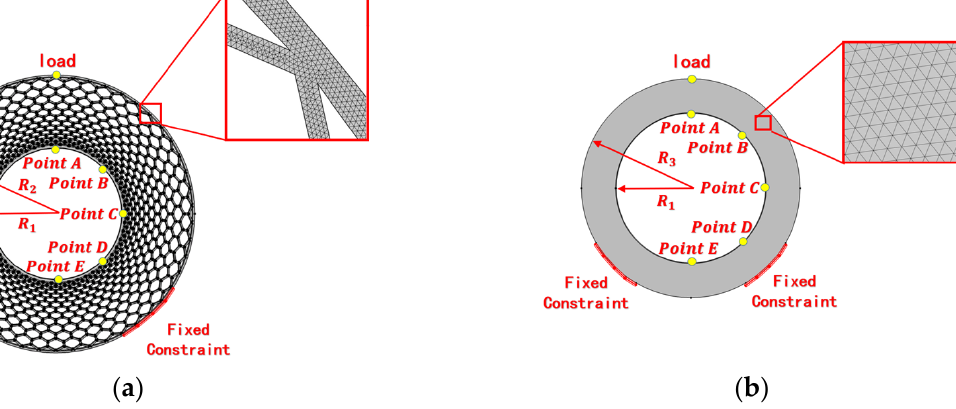
Figure 6. Simulated model diagram. ( a ) Simulated model for the pentamode lattice-ring structure; ( b ) simulated model for the solid ring with equal mass.